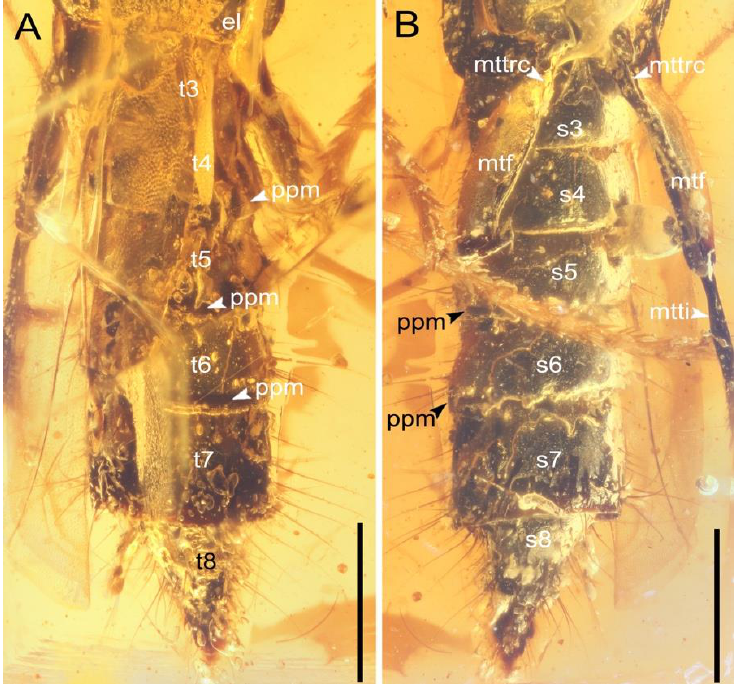
Figure 4. Abdomen of Priochirus trisclerite sp. nov., holotype, QUST-SHUO-0003. ( A ) Abdomen, dorsal view. ( B ) Abdomen, ventral view. Abbreviations: el, elytron; mtf, metafemur; mtti, metatibia; mttrc, metatrochanter; ppm, punctation on posterior margin; s3 – 8, sternites III – VIII; t3 – 8, tergites III – VIII. Scale bars = 0.5 mm.